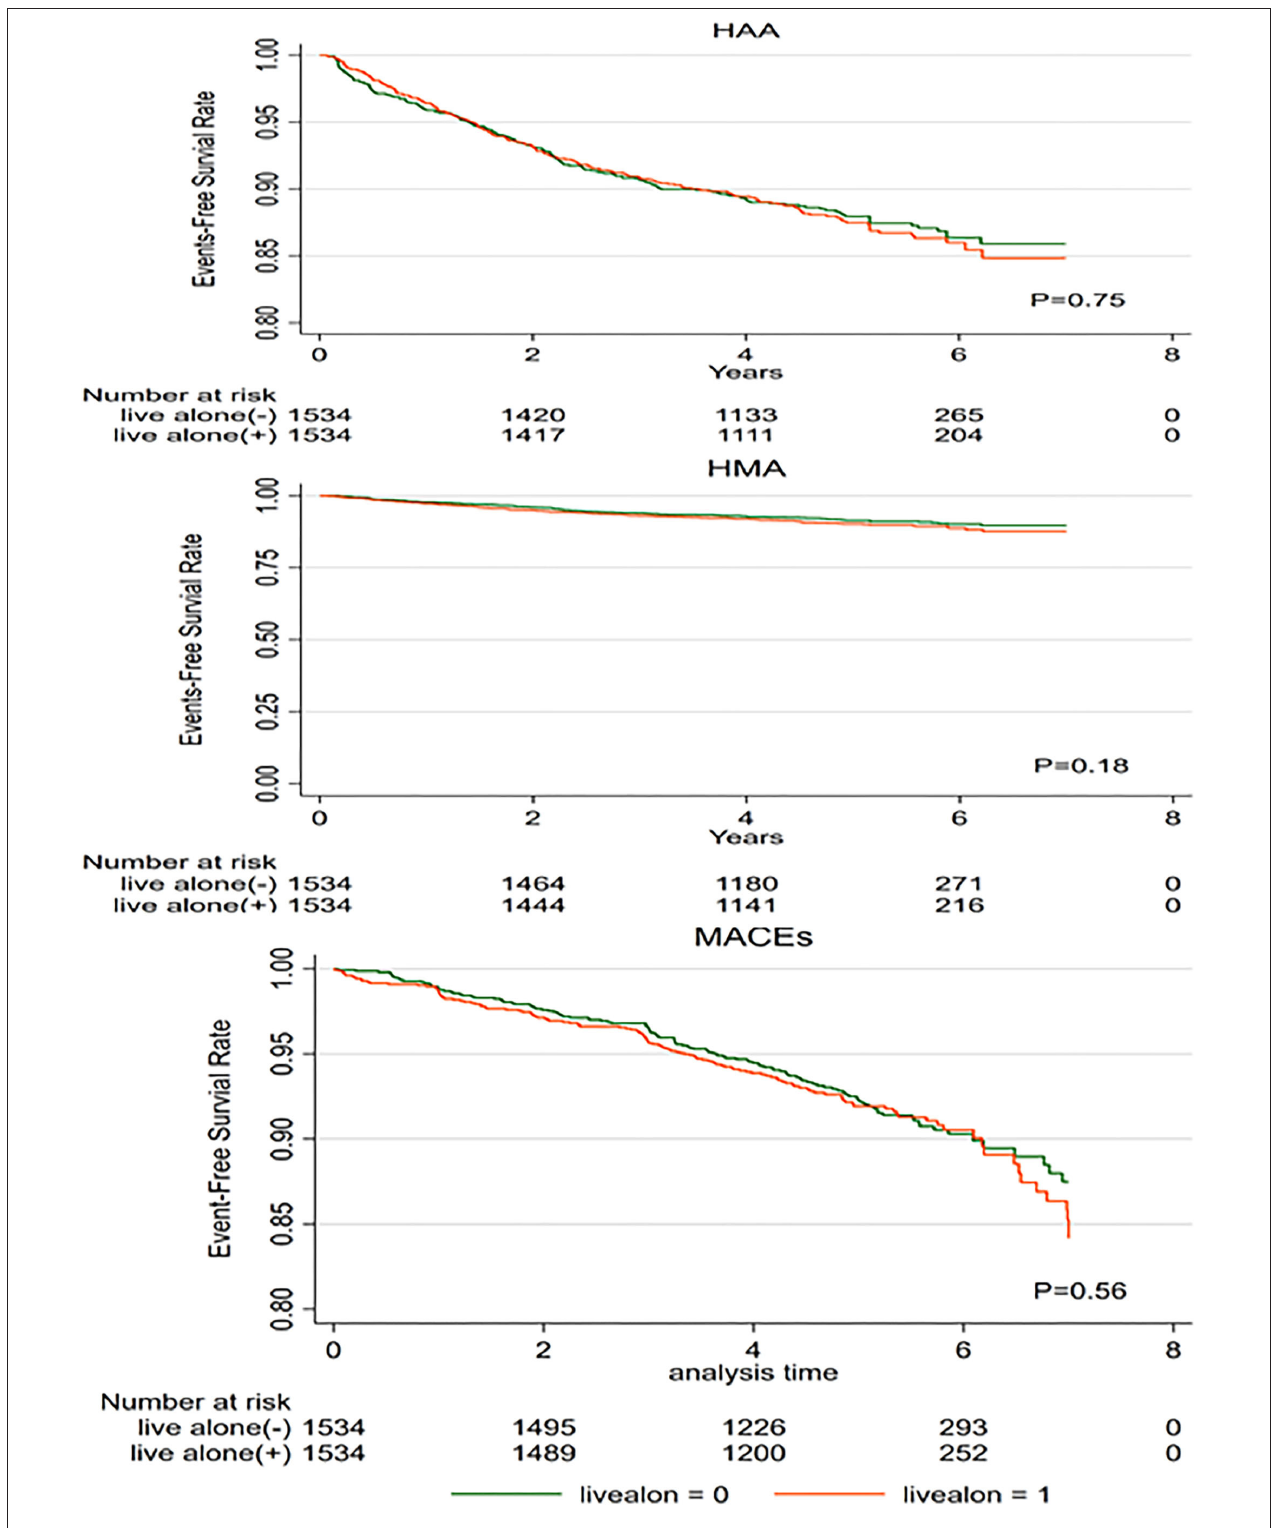
FIGURE 2 | Kaplan–Meier survival curves for the selected health events in propensity score-matched patients with type 2 diabetes. MACEs, major adverse cardiovascular events; HAA, hypoglycemia requiring any assistance; HMA, hypoglycemia requiring medical assistance.